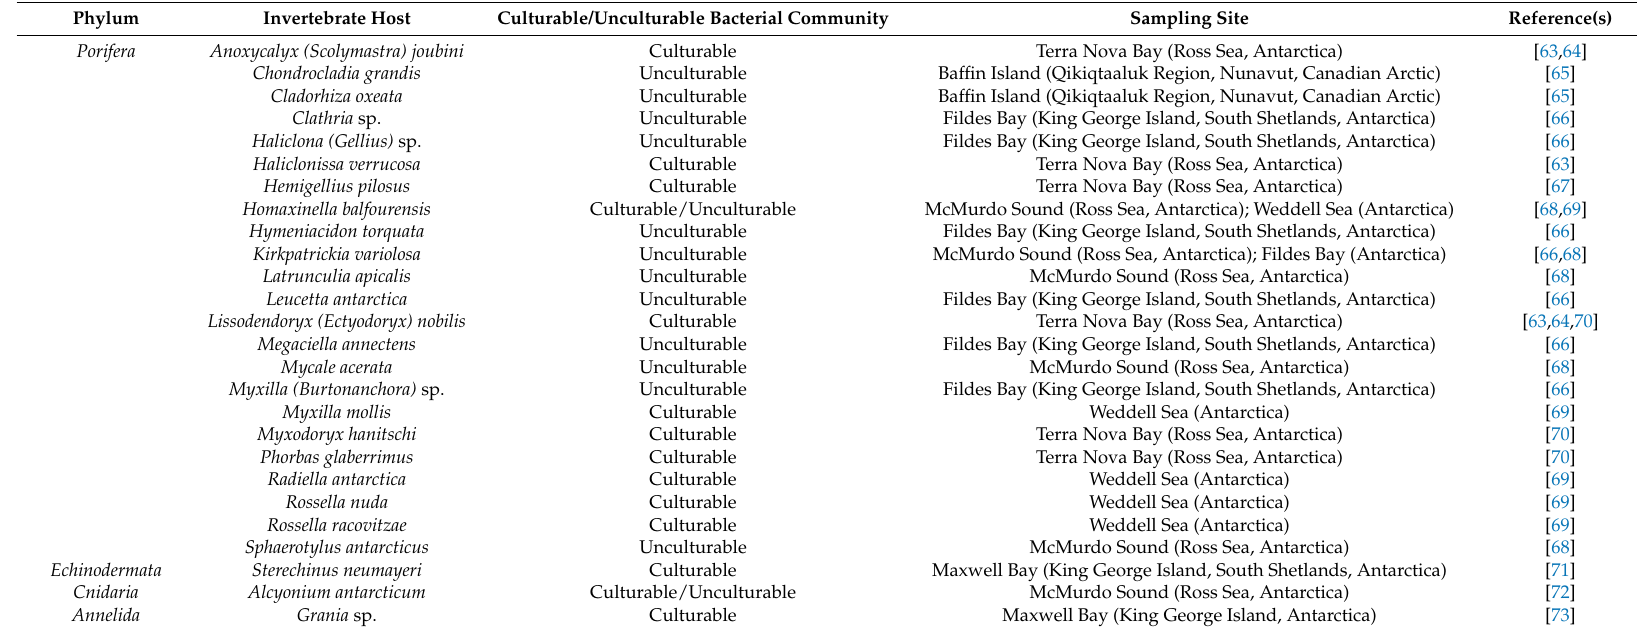
Table 1. Invertebrate hosts analyzed to date for the associated bacterial